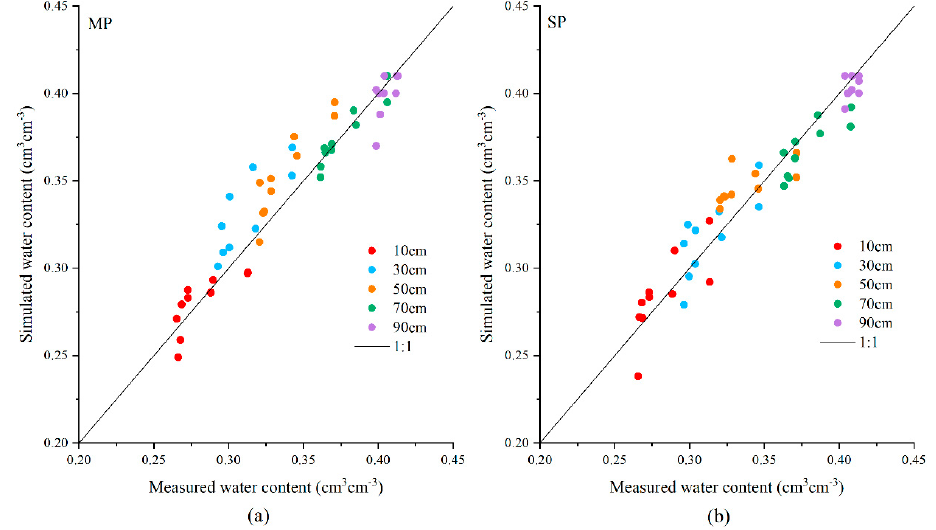
Figure 2. Comparison of measured and simulated water content in different soil depth (10, 30, 50, 70, 90 cm). ( a ) MP indicate the calibration based on the field-measured data at the middle position of the experimental lysimeter. ( b ) SP indicates the calibration based on the field-measured data at the side position of the experimental lysimeter.